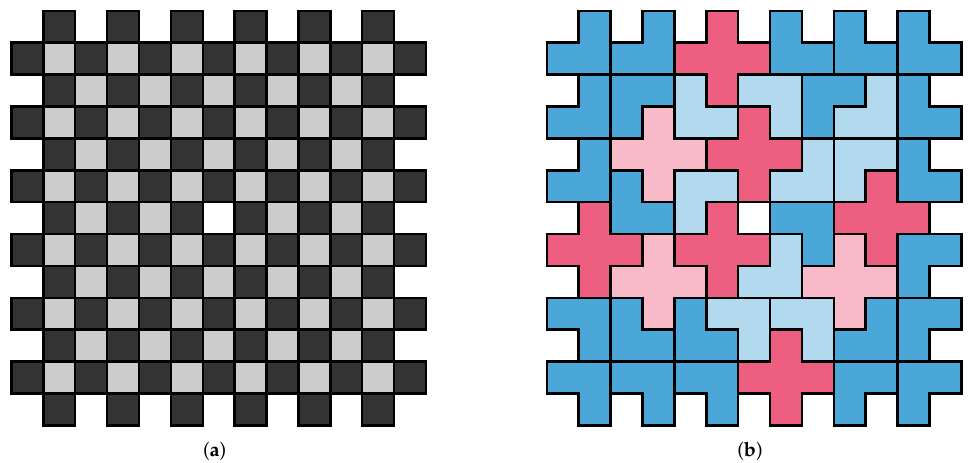
Figure 19. Target region and a tiling solution for Example 7: ( a ) The target region (cid:98) R , a checkerboard coloured jagged-square shaped region with a single ‘hole’ in the middle. ( b ) Successful tiling of the target region (cid:98) R using 33 copies of an L-shaped trimino and 9 copies of the cross-shaped pentomino. The optimal solution corresponds to the fourth pariomino tiling subproblem in Table 3 where we use 24 copies of P + , 9 copies of P − , 6 copies of P + , and 3 copies of P − . The pariominoes P + , P − , P + and 2 2 2 1 1 1 1 P − are coloured dark blue, light blue, dark red, and light red, 2